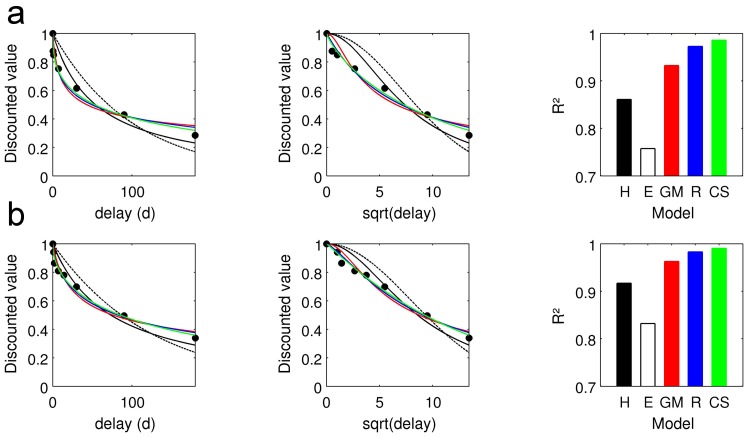
Discount function fit to median indifference points (a: n = 50, b: n = 55).Leftmost panels plot subjective discounted value against time, center panels plot value against time1/2 to improve visualization of the shorter delays. R2 for each model function is plotted in the rightmost panels.